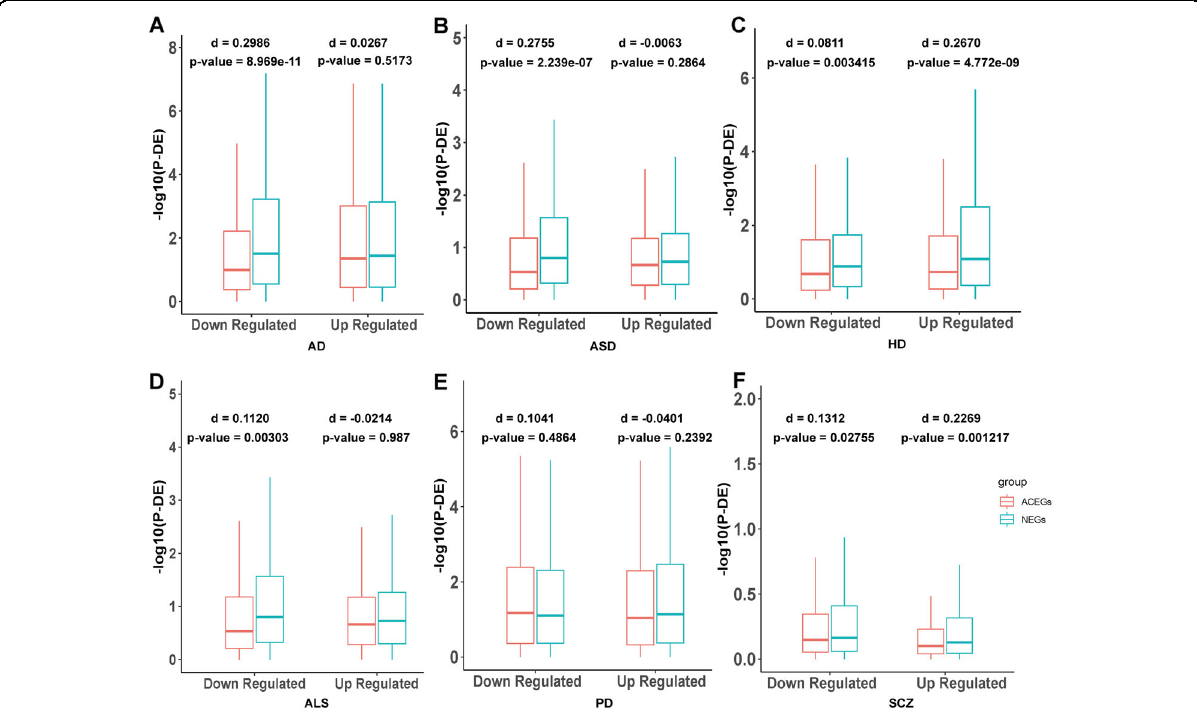
Fig. 2 Differential expression (DE) among control and neuropsychiatric disorders in brain tissue transcriptome data. a DE p value of Neuronal Essential Genes (NEGs) and Achilles Project-speci fi c essential genes (ACEGs) in GSE95587 (fusiform gyrus tissue sections from Alzheimer ’ s disease (AD) patients and control). b DE p value of NEGs and ACEGs in GSE64018 (brain cortex from Autism spectrum disorder (ASD) patients and controls). c DE p value of NEGs and ACEGs in GSE64810 (BA9 tissue from Huntington ’ s Disease (HD) patients and controls). d DE p value of NEGs and ACEGs in GSE122649 (brain cortex from Amyotrophic Lateral Sclerosis (ALS) patients and controls). e DE p value of NEGs and ACEGs in GSE68719 (BA9 tissue from Parkinson ’ s disease (PD) patients and controls). f DE p value of NEGs and ACEGs in CommondMind Consortium data (brain cortex from schizophrenia (SCZ) patients and